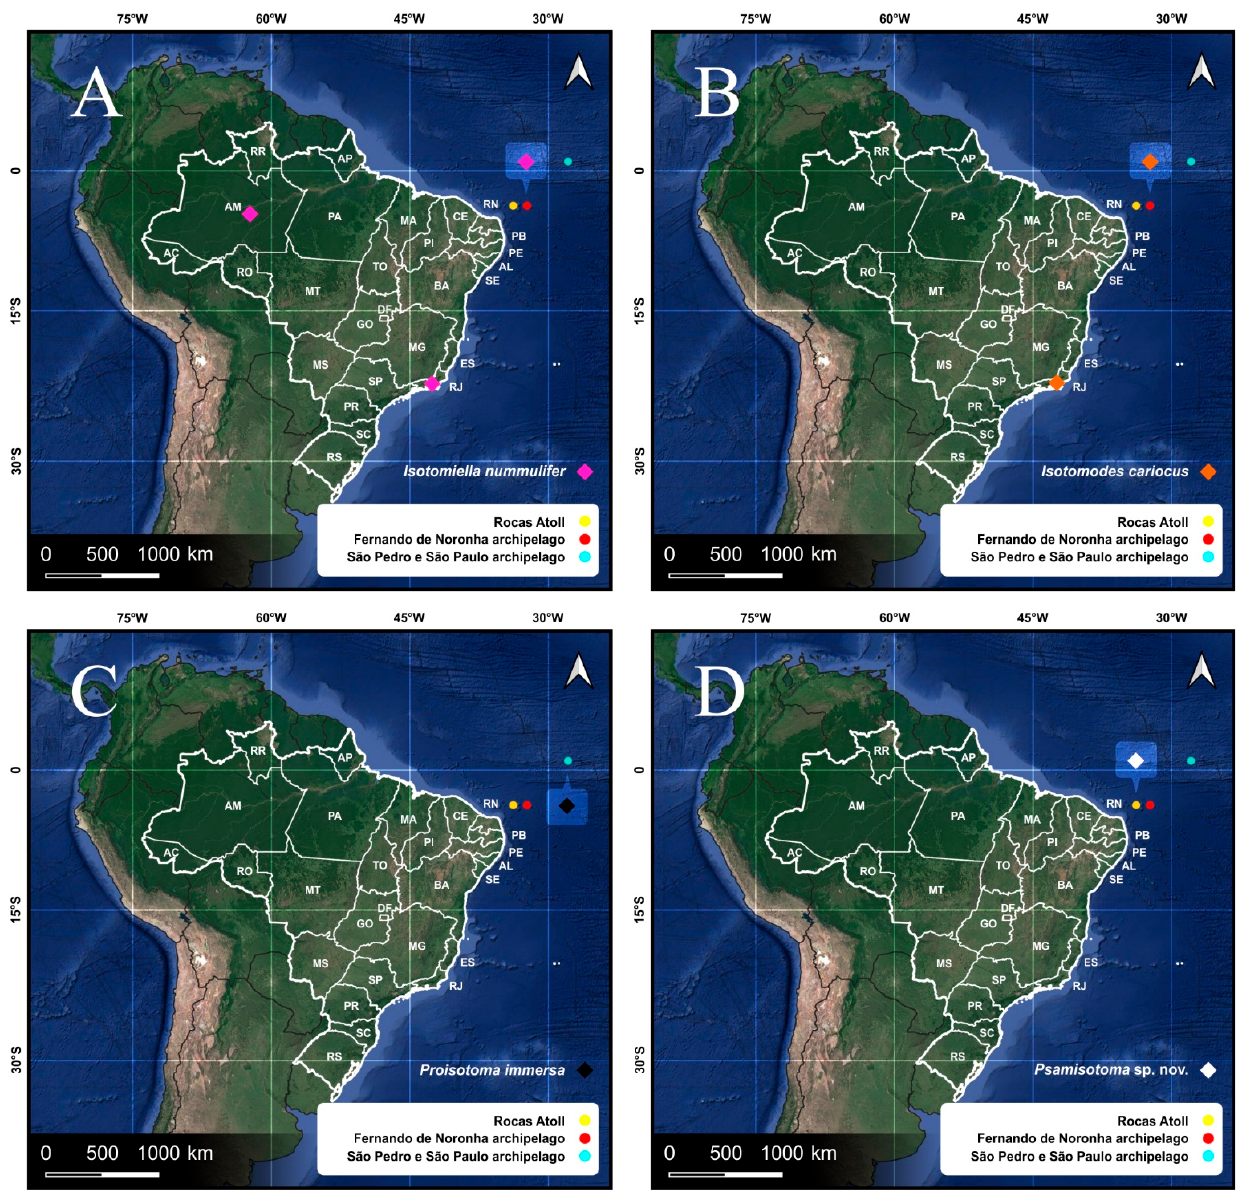
Figure 4. Distribution map for Isotomidae records in Brazil mainland and oceanic islands. ( A ). Isotomiella nummulifer ; ( B ). Isotomodes cariocus ; ( C ). Proisotoma immersa ; ( D ). Psammisotoma sp . Psammisotoma Greenslade & Deharveng, 1986